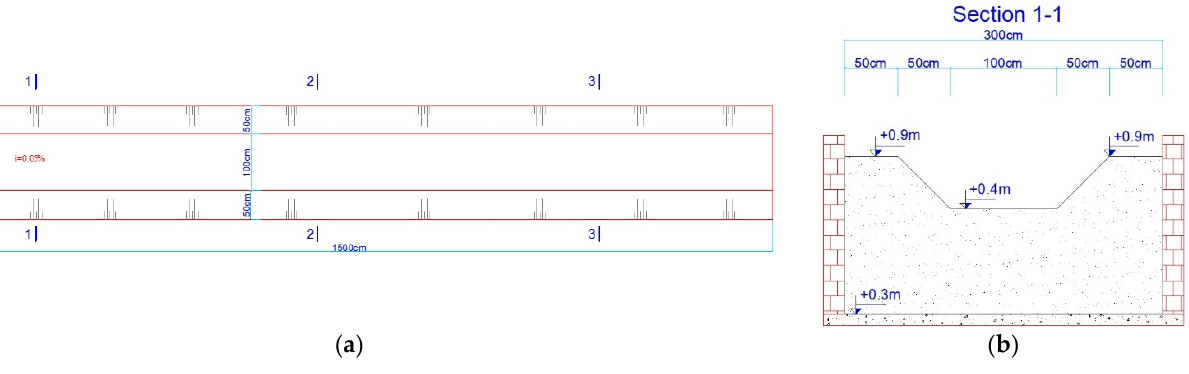
Figure 2. The geometry of experiment: ( a ) plain view; ( b ) cross section